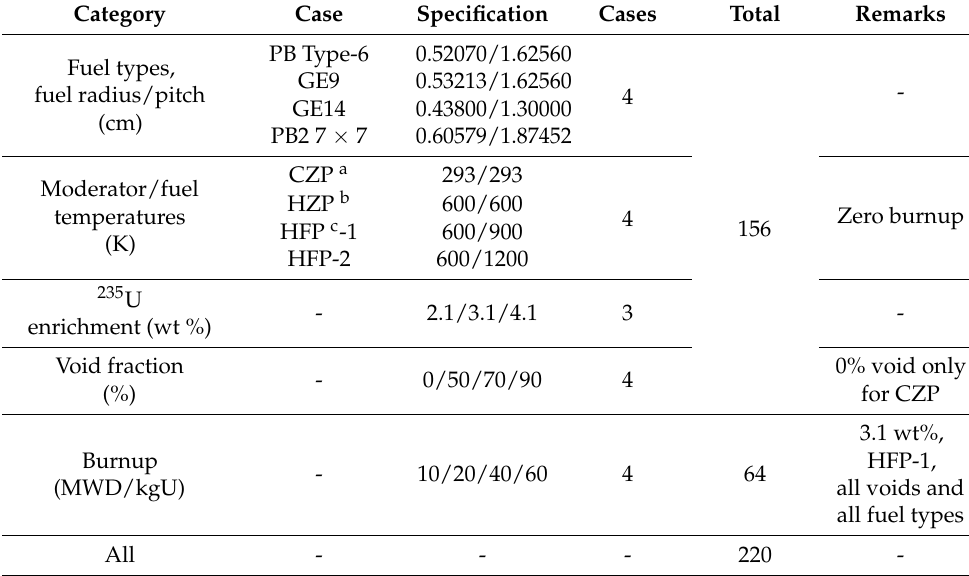
Table 3. Benchmark cases for the BWR single pins.